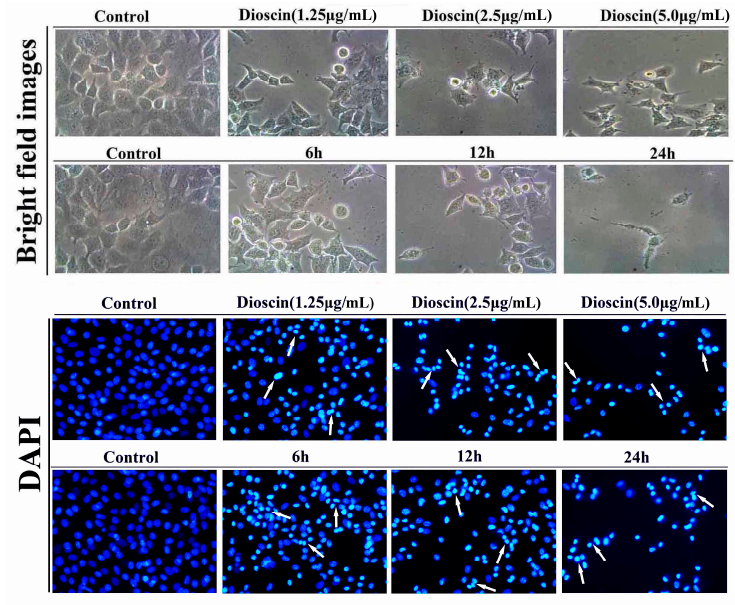
Figure 3. Morphological changes of HeLa cells treated by dioscin. Molecules 2016 , 21 , 730